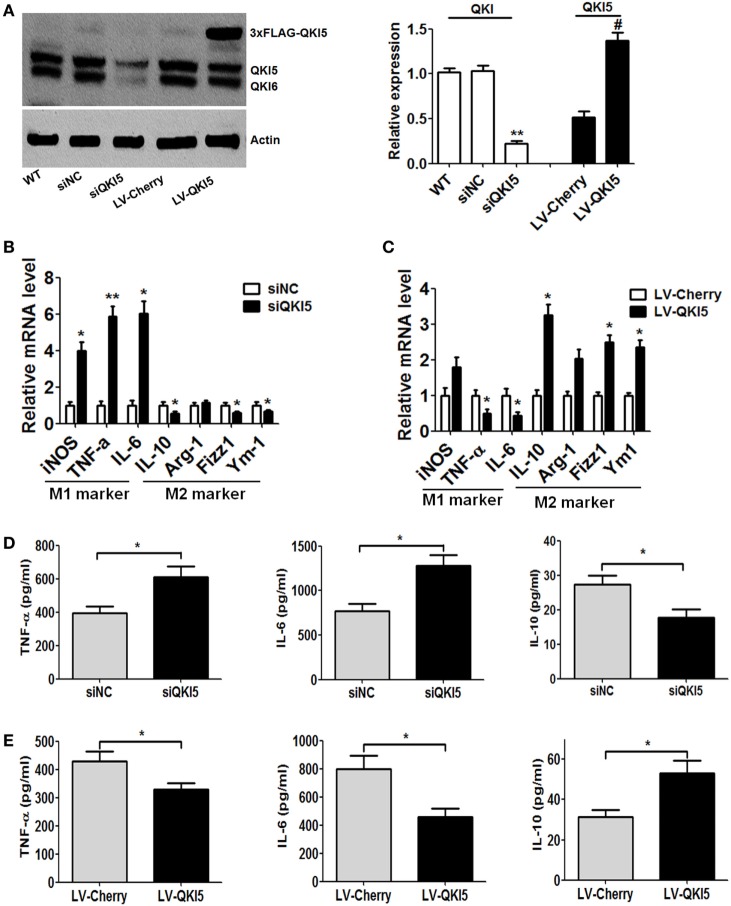
Dysregulation of quaking (QKI) expression influenced the production of macrophage lineage-specific cytokines. (A) Western blots were performed to determine the effects of QKI knockdown (siQKI5 and siNC was a scramble control) or overexpression (LV-QKI5, and LV-Cherry was a control) in RAW 264.7 cells using an anti-QKI antibody. One representative immunoblot is shown (on the left) and the graph (on the right) presents quantification of the band intensity for immunoblots from three independent experiments. **p < 0.01 versus WT control; #p < 0.05 versus LV-Cherry group. (B,C) Real-time PCR analysis of relative mRNA expression of the M1 markers (iNOS, TNF-α, and IL-6) and M2 markers (IL-10, Arg-1, Fizz1, and Ym1) by QKI silencing (B) or overexpression (C) RAW 264.7 cells stimulated with 1 µg/ml lipopolysaccharide (LPS) for 16 h. (D,E) Enzyme-linked immunosorbent assay (ELISA) of the production of TNF-α, IL-6, and IL-10 by QKI-silenced (D) or overexpressed (E) RAW 264.7 cells stimulated for 24 h with 1 µg/ml LPS. All the bars represent the mean of measurements from three independent experiments, and the error bars indicate ±SEM. *p < 0.05, **p < 0.01.